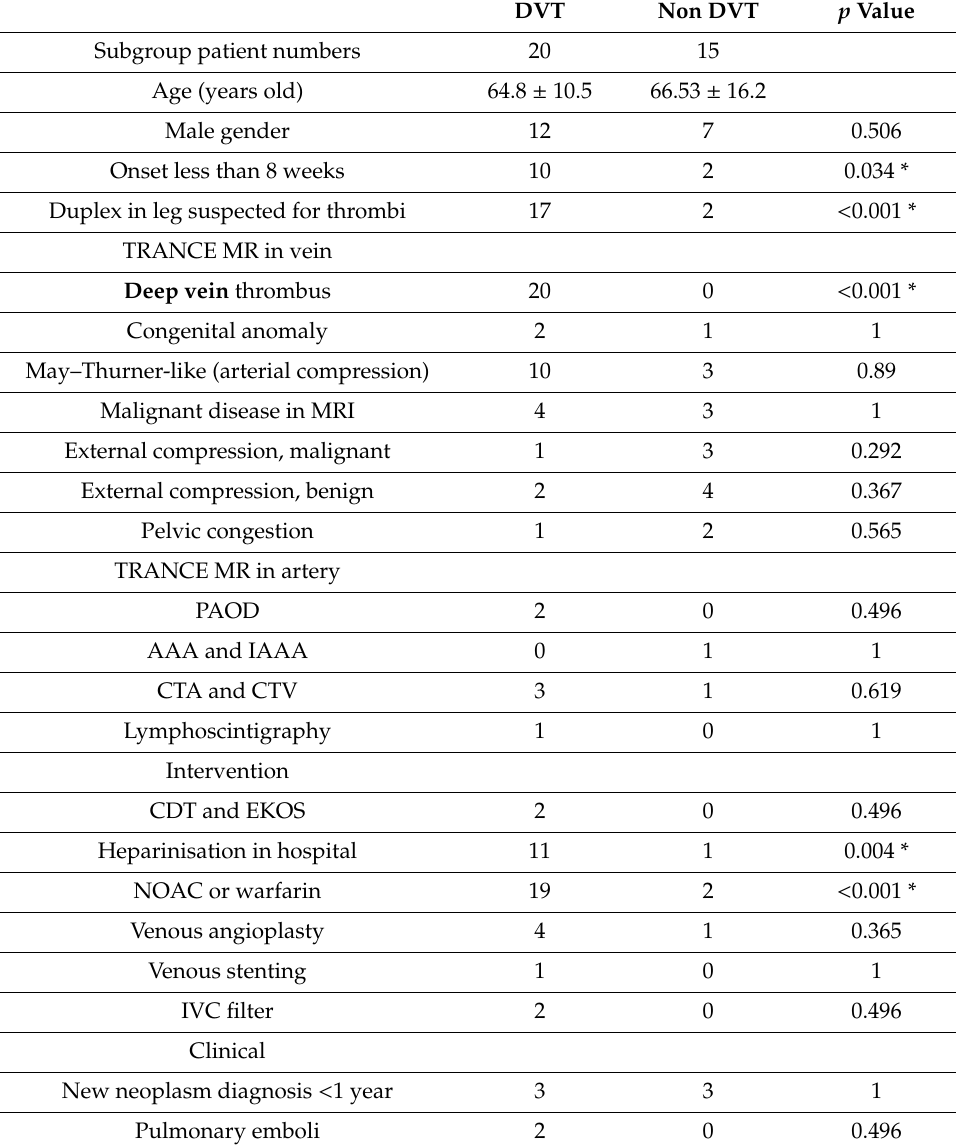
Table 2. Details of venous obstructive syndrome ( n = 35